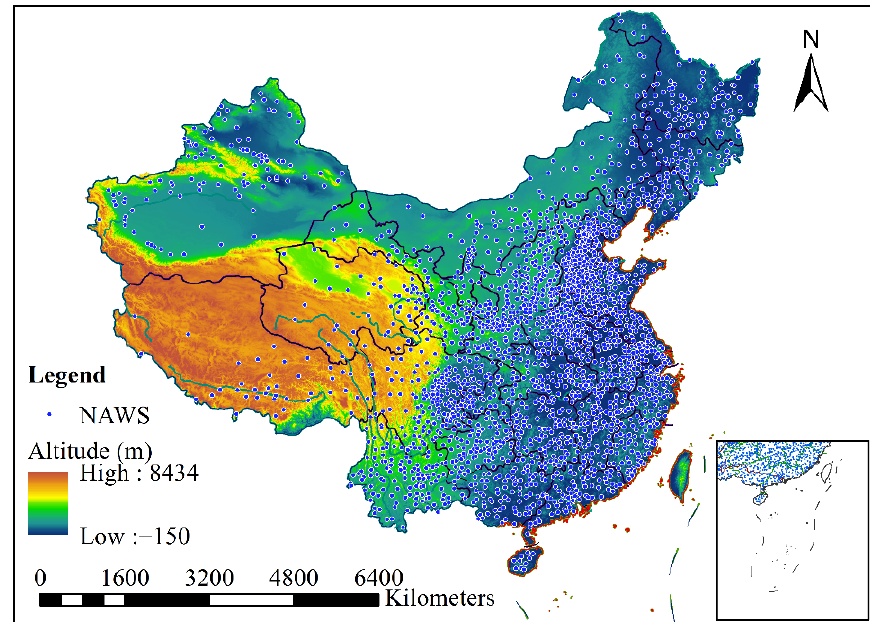
Figure 1. Distribution of verification weather stations (national stations).